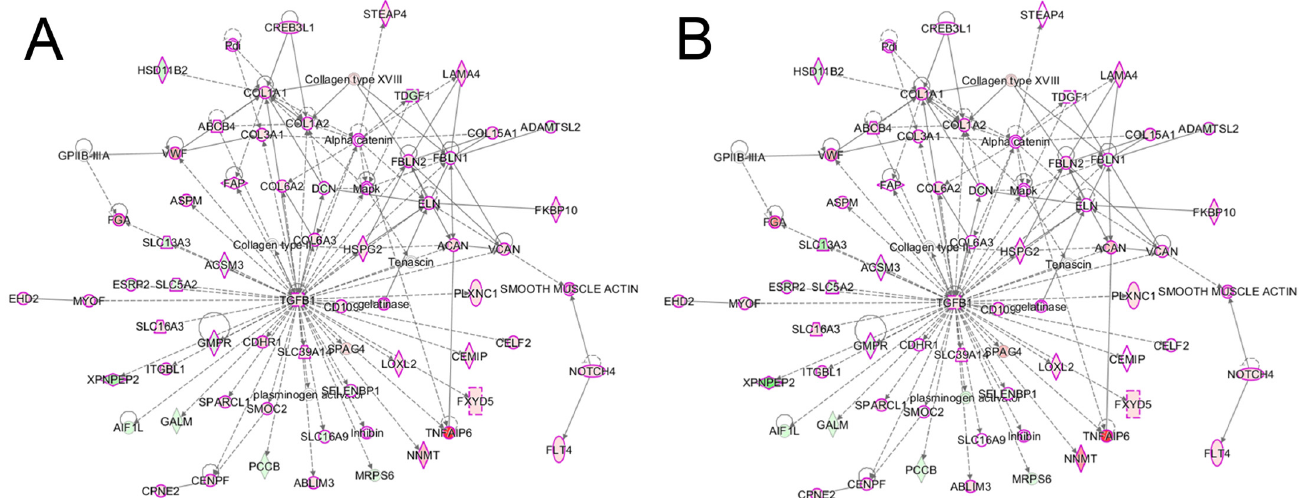
Fig 5. Gene network. The most differentially affected network with the central role of TGFB1 in (A) FFPE samples and B) RNAlater data sets. Proteins with cancer involvement are marked with purple outline . Red fill indicates overrepresentation of the gene in ccRCC , green indicates under-representation . Color intensity reflects range of fold change